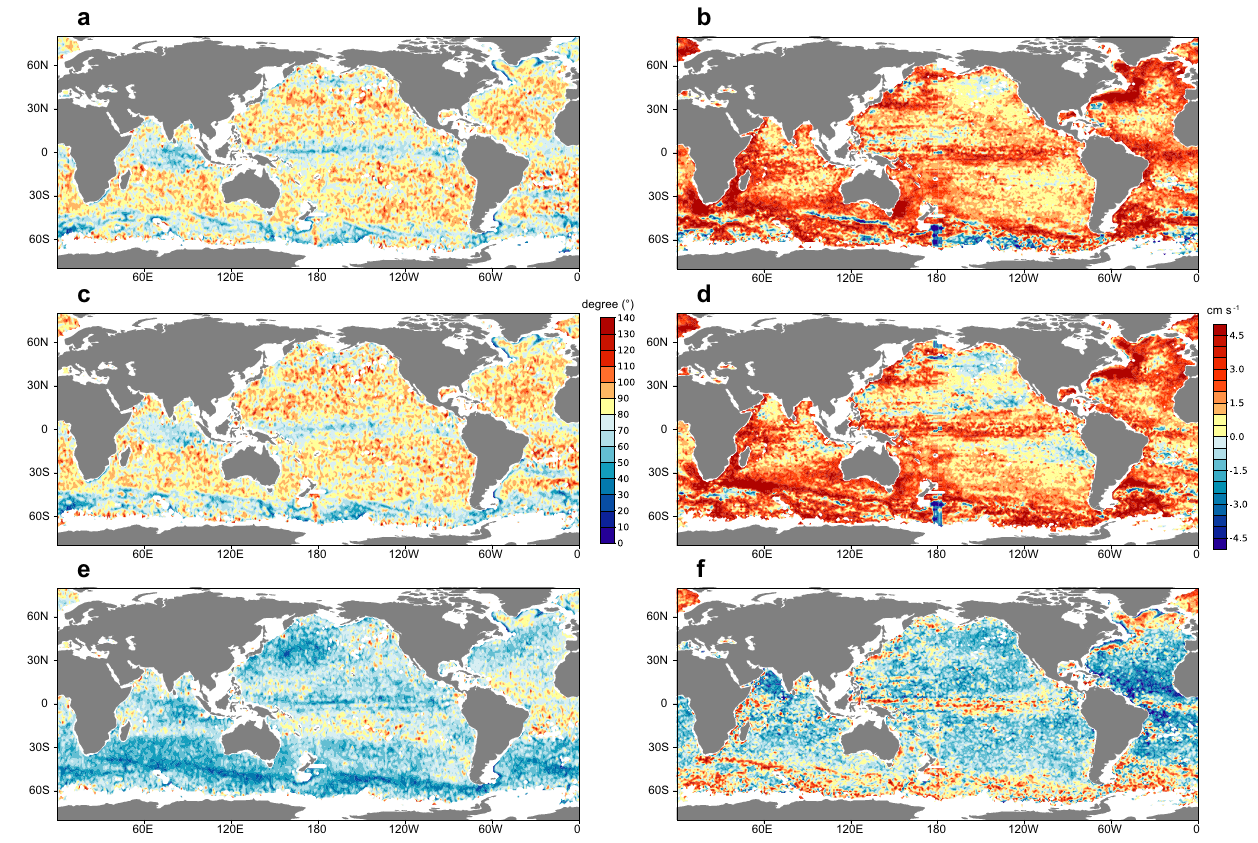
Fig. 2 | Global spatial distribution of DOD (Difference of direction) and DOV (Difference of velocity) for ECCO2 (a, b), OFES (c, d), CMEMS (e, f). The ( a, c, e ) panels: mean DOD during 2001 – 2020 (shaded color). Warm (Cool) color indicates